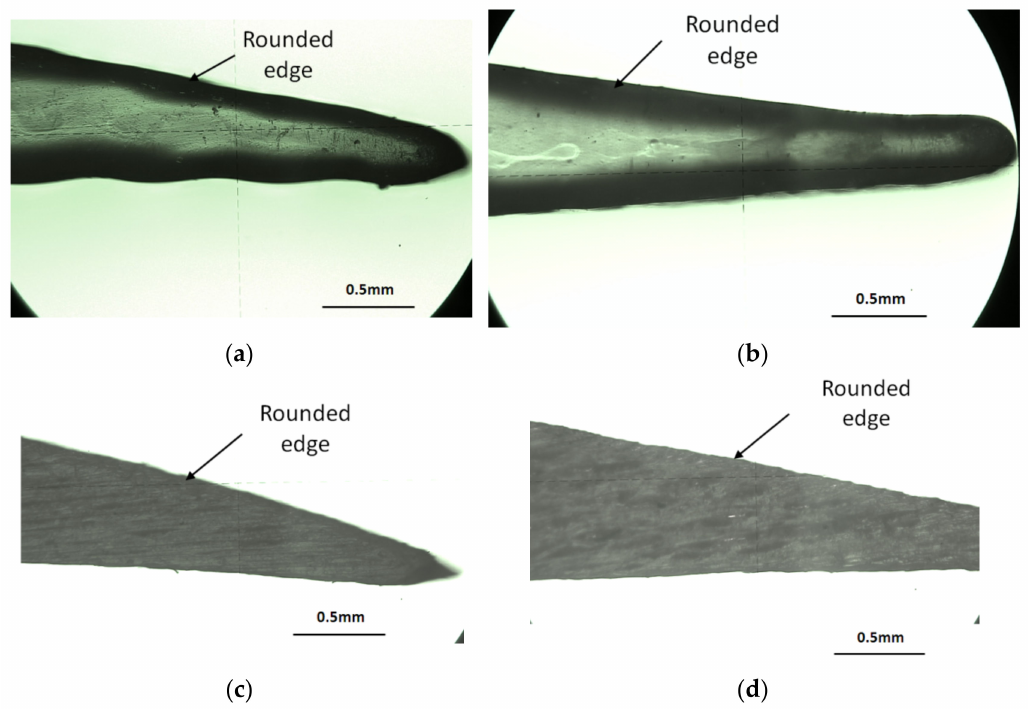
Figure 20. Lateral surface view of the airfoil on trailing edge zone: ( a ) glossy XY; ( b ) glossy YX; ( c ) matte XY; ( d ) matte